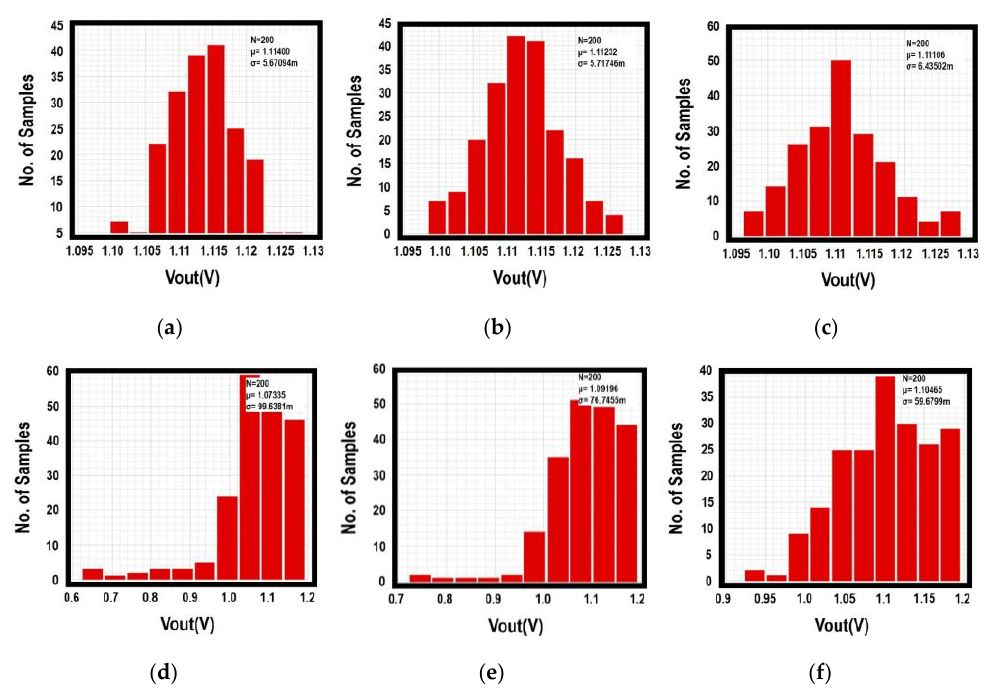
Figure 15. Monte-Carlo simulation of V OUT of the proposed enhancer ( a ) @−20 °C; ( b ) @27 °C; ( c ) @80 °C; and conventional enhancer ( d ) @−20 °C; ( e ) @27 °C; ( f ) @80 °C.